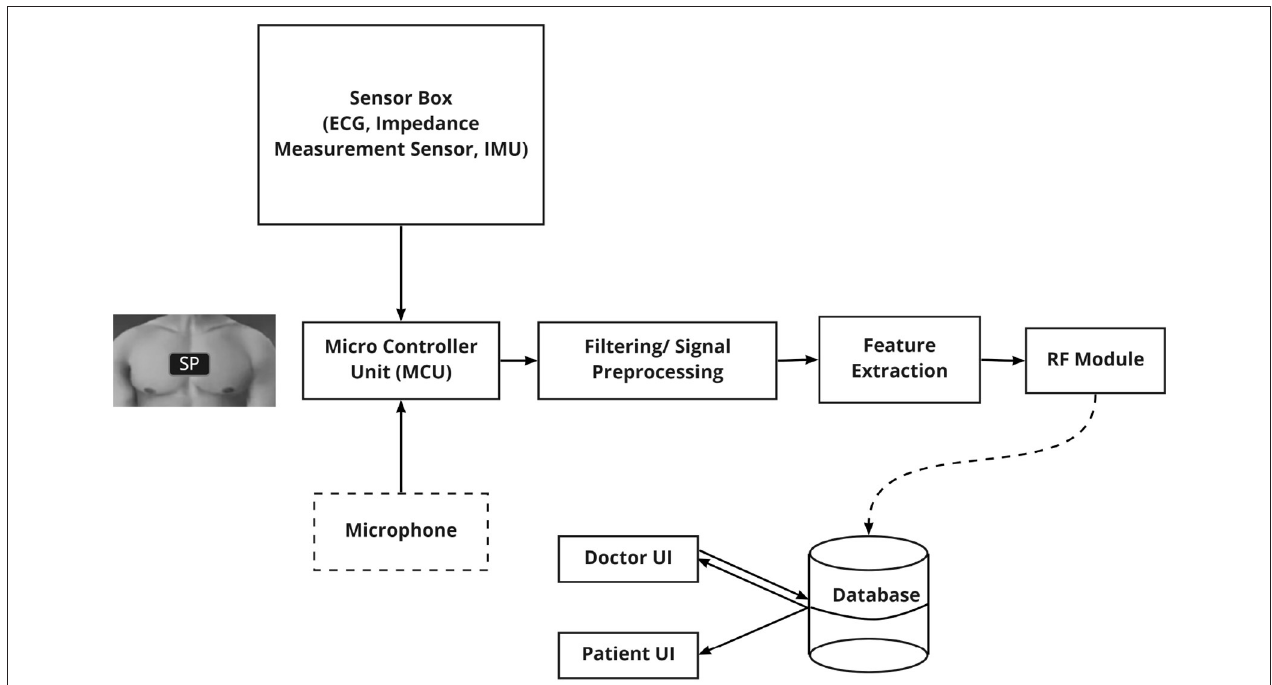
FIGURE 1 | The hardware architecture of the SP: consists of a micro-controller unit (MCU) which is connected to ECG sensor, Impedance Measurement unit, Inertial Measurement Unit (IMU) and a microphone.